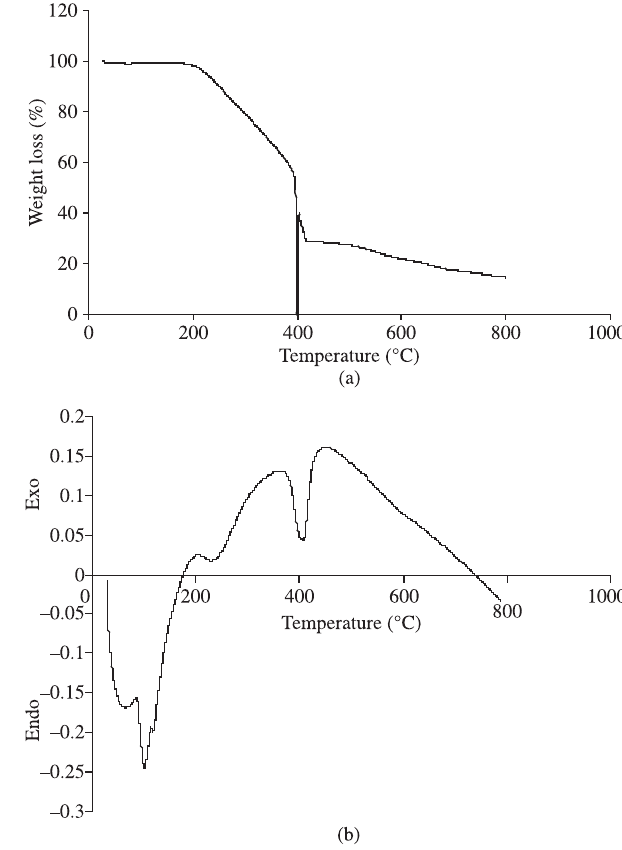
Figure 3. Thermogravimetry (a)/Differential thermal analysis (b) curves of mesoporous Mn – organophosphate molecular sieve.